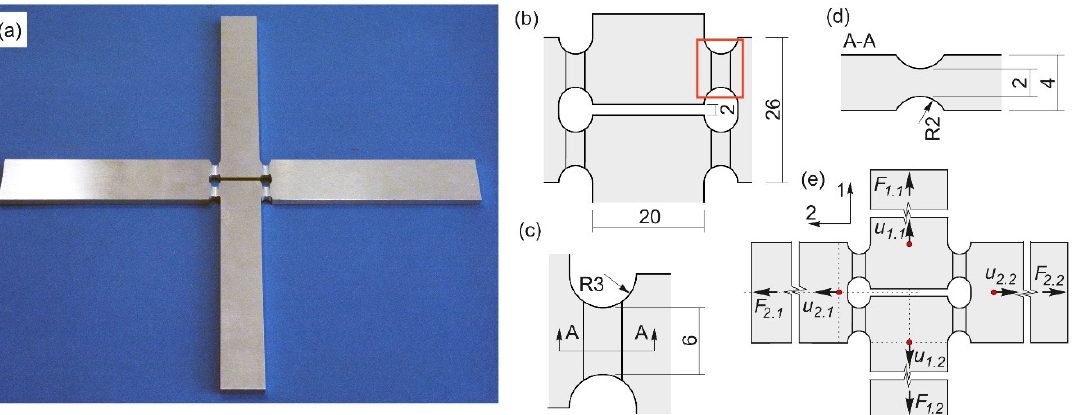
Figure 1. Geometry of the H-specimen: ( a ) photo, ( b ) central part, ( c ) detail notch, ( d ) cross-section, ( e ) notation.